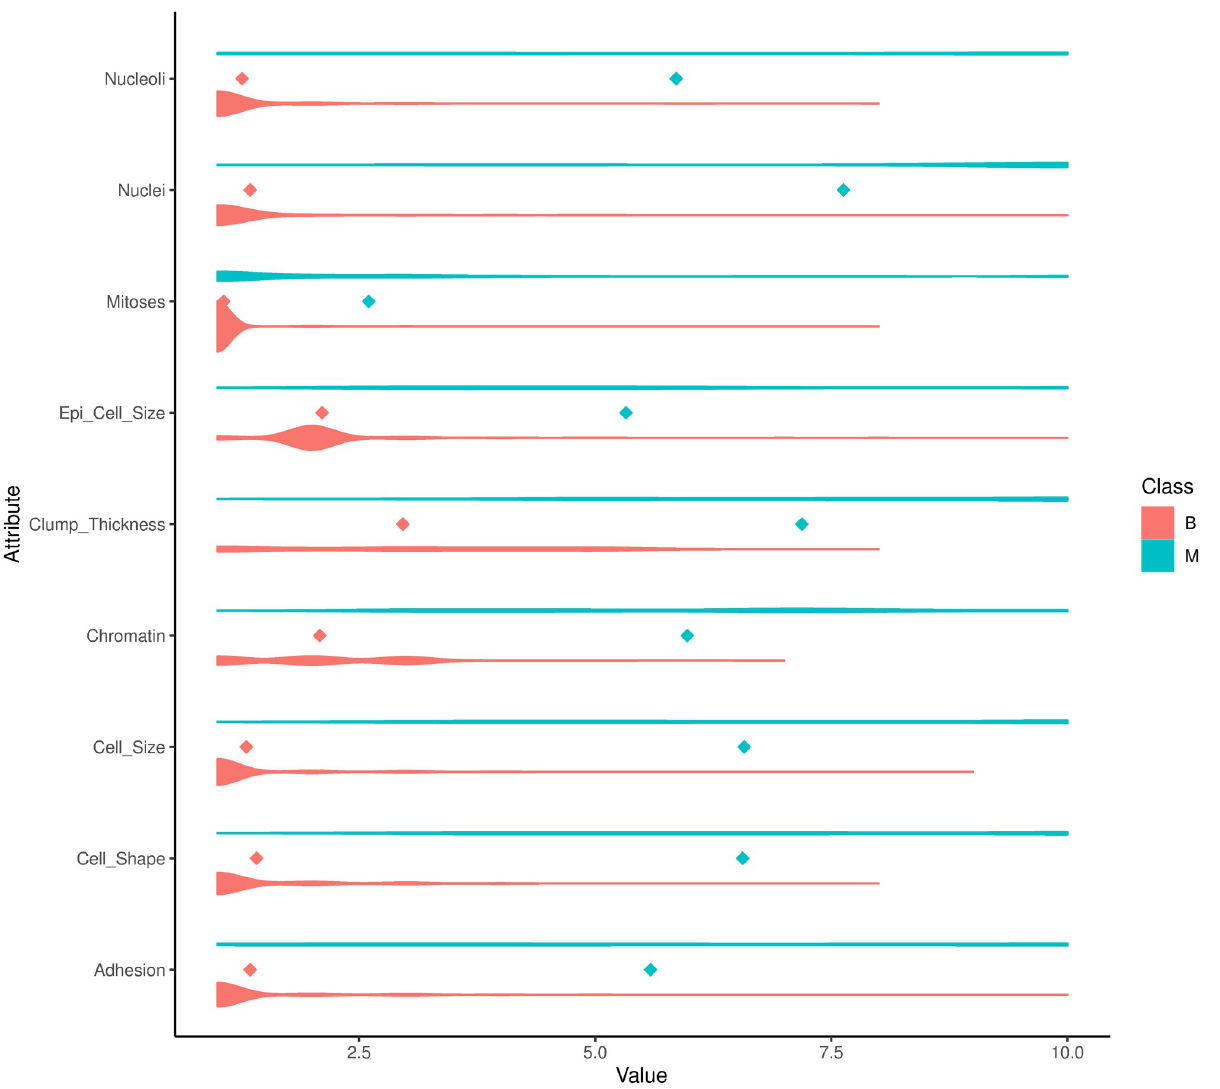
Fig 3. Distribution of the target “Class” attribute in the